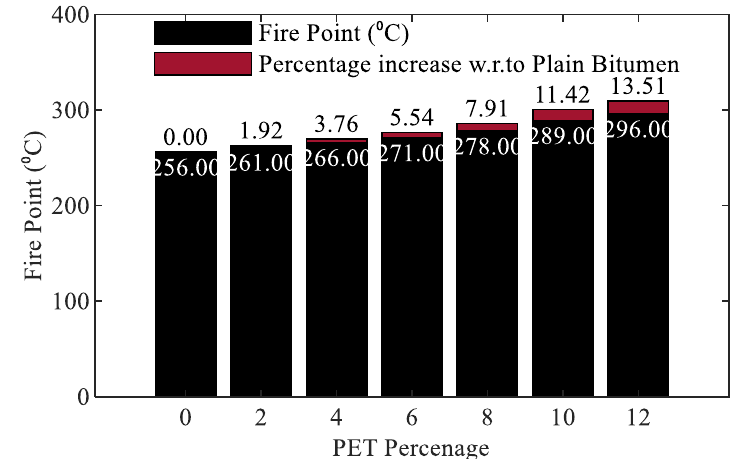
Fig. 23 Variation of fire point with PET content